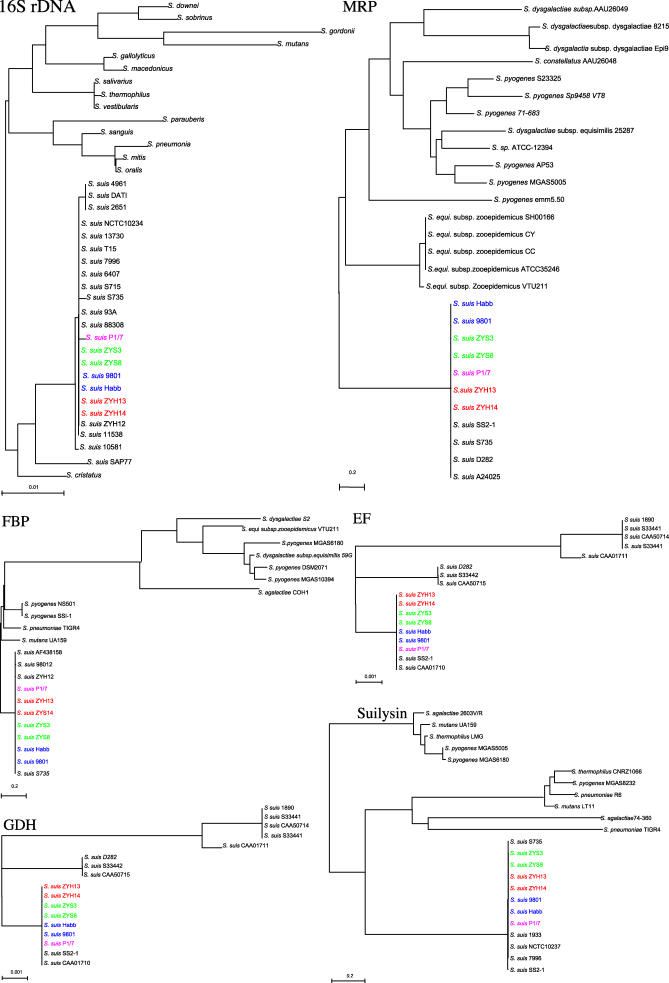
Phylogenetic Trees of Six Representative Isolates Based on Comparison of 16S rDNA and Five Putative Virulence-Associated-Factor Genes with Known SequencesSwine isolates from Sichuan (
S. suis ZYS3 and
S. suis ZYS8) labeled in green, human isolates (
S. suis ZYH13 and
S. suis ZYH14) from Sichuan labeled in red, Jiangsu isolates from 1998 (
S. suis 9801 and
S. suis Habb) labeled in blue, and the standard highly virulent strain
S. suis P1/7 labeled in pink. All representative strains from other streptococcus species or isolates of
S. suis 2 are as indicated in the tree.